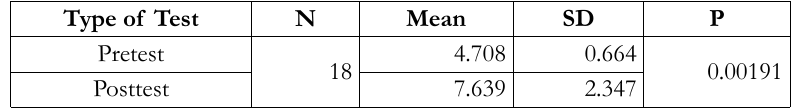
Table 3. T-test results for PAT1